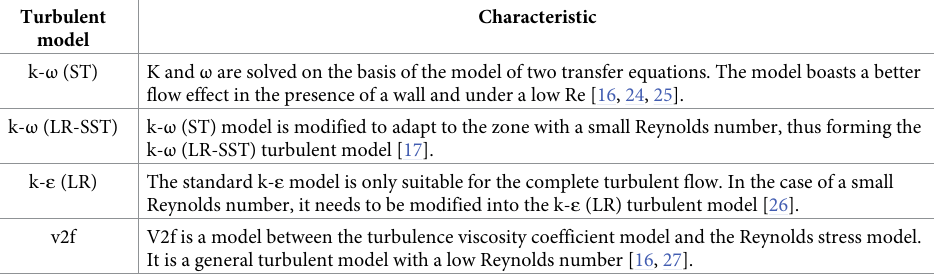
Table 4. Characteristics of turbulent